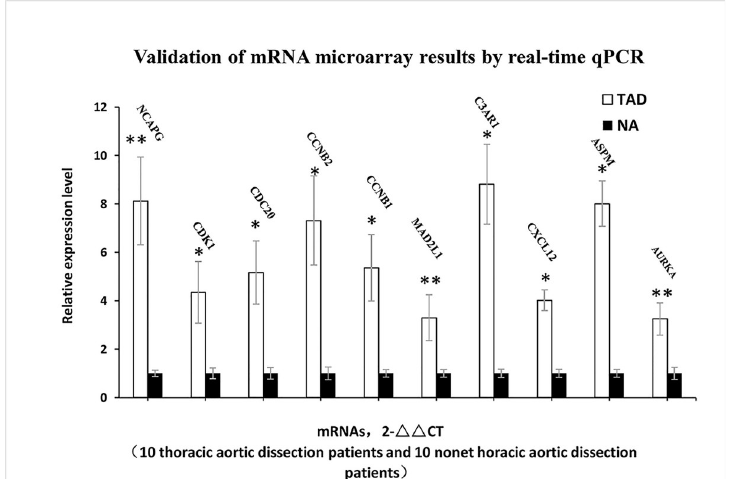
Fig 7. Validation of the mRNA microarray results by real-time qPCR. mRNA microarray results were verified by real-time qPCR between the TAD group (n = 10) and the NT group (n = 10). All samples were normalized to the expression of GAPDH, and the relative expression levels of each gene were analyzed using the 2- ΔΔ Ct method. � P < 0.05, �� P < 0.01.